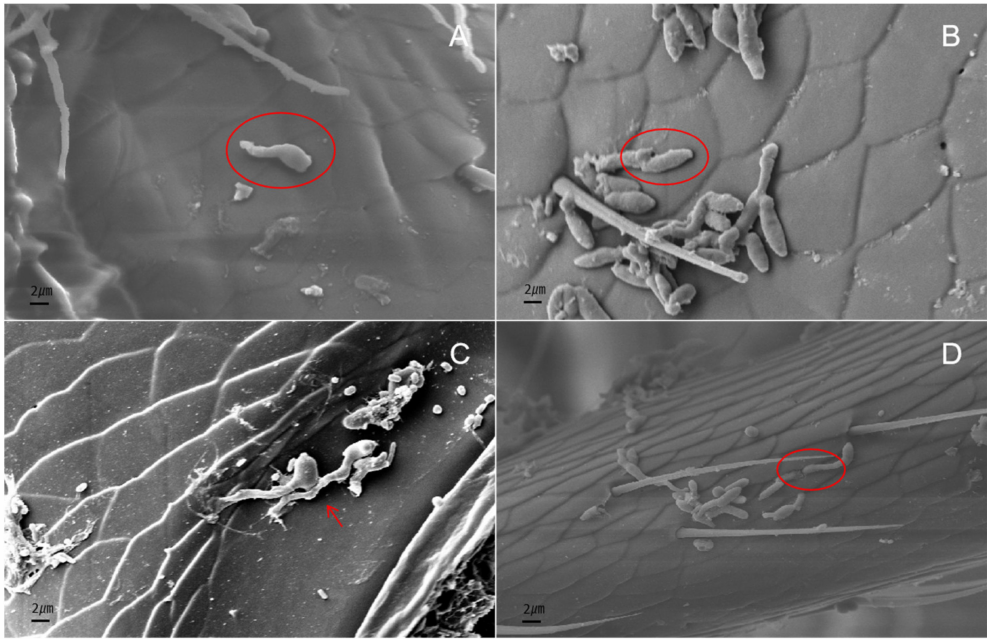
Figure 7. SEM observations of the inoculation of I. javanica for 12–24 h. ( A ) Spores germinate to form a short dental canal; ( B ) apical expansion to form an adherent cell; ( C ) adnexal extension; ( D ) bud tube invades the body